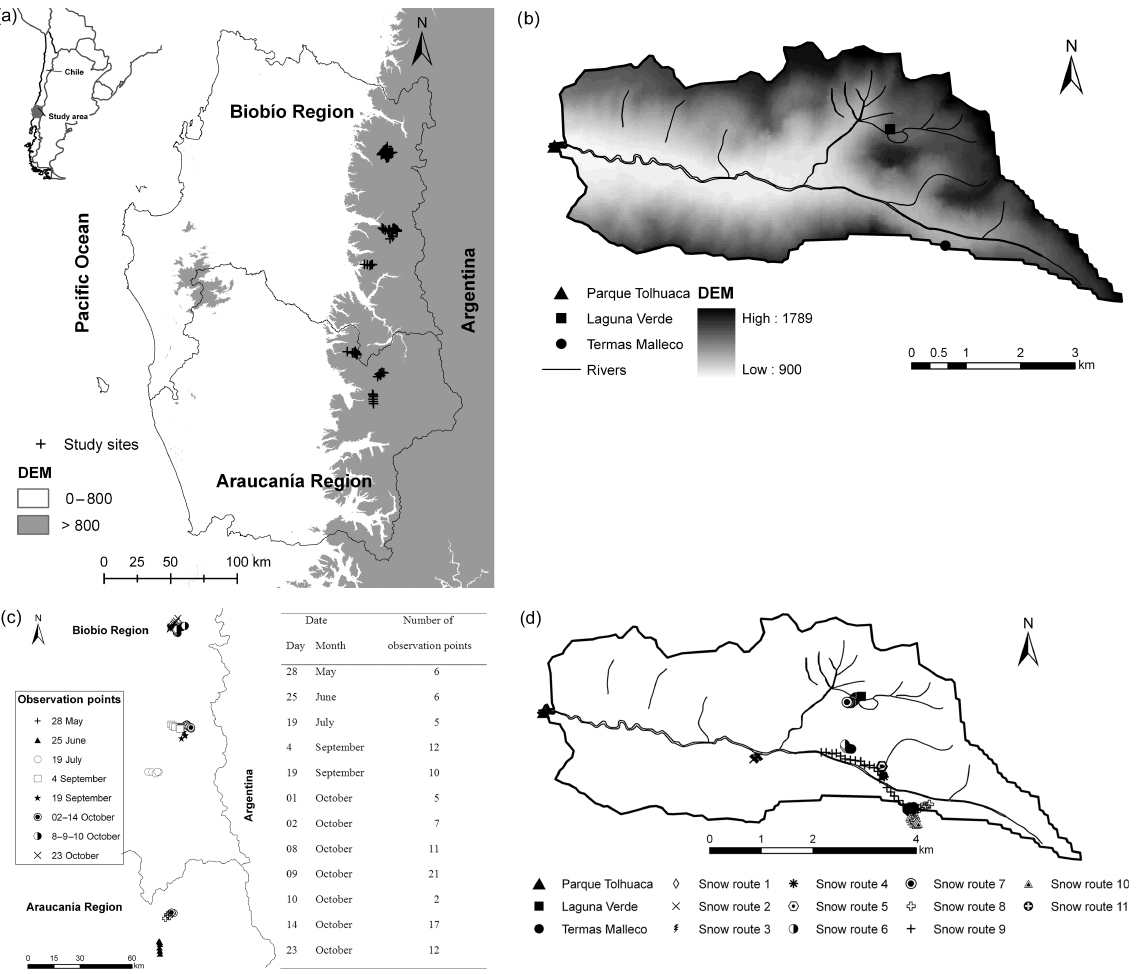
Figure 2. (a) Study sites for MOD10A2 validation. (b) Location of the meteorological stations for continuous monitoring of snow depth. (c) Location and date of 1-day observation points. (d) Location of the snow